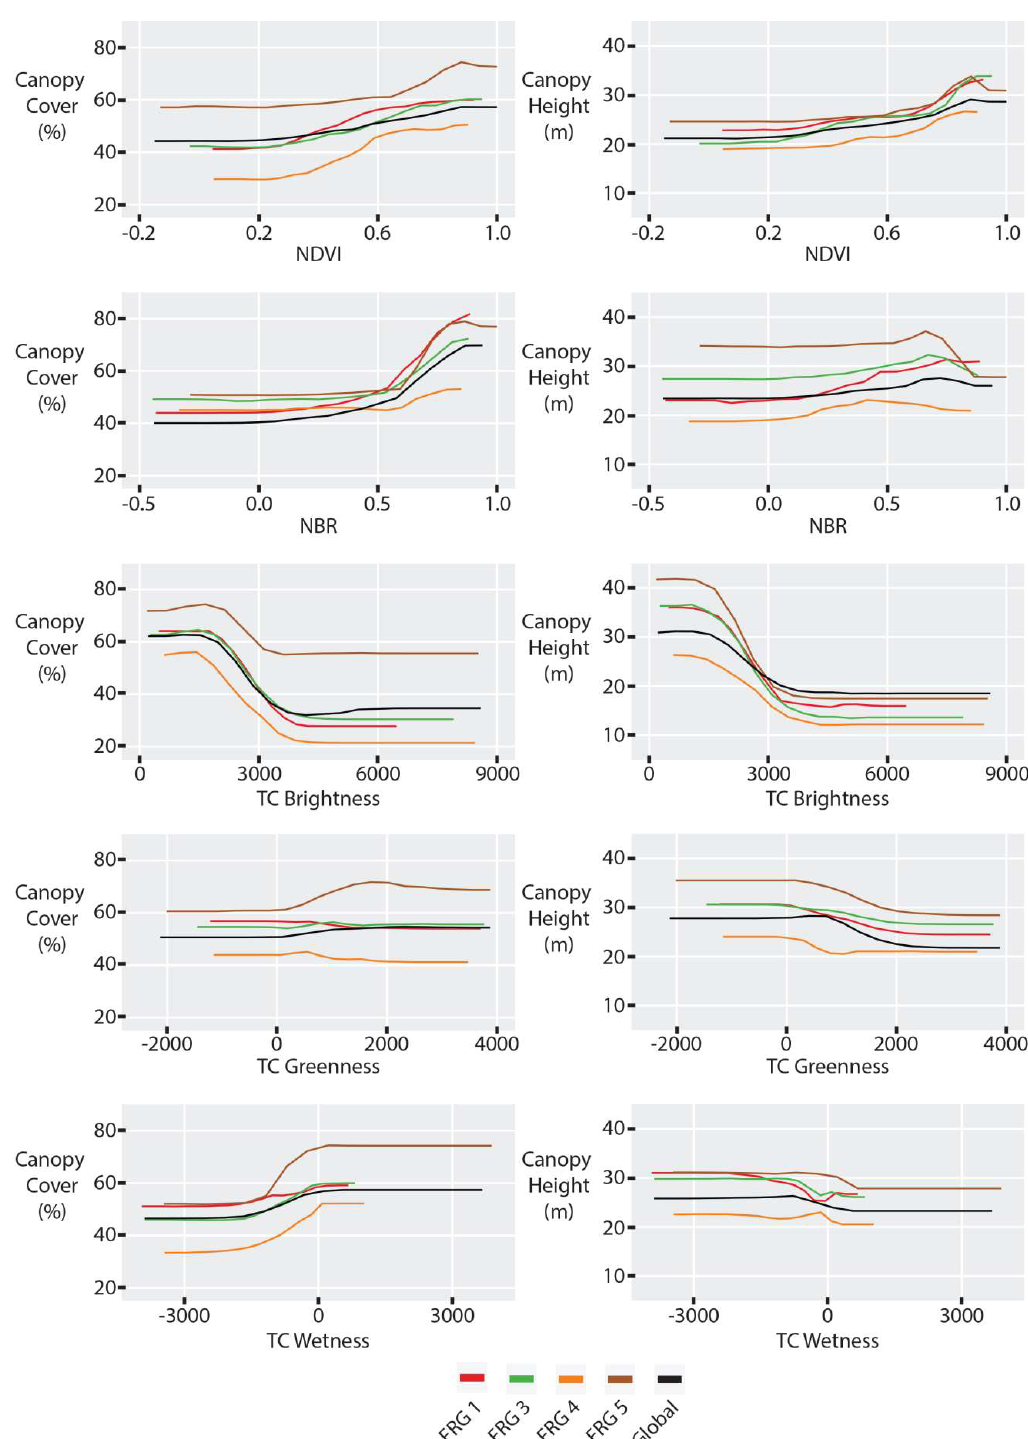
Figure 5. Partial dependence plots for each predictor variable (x-axes ) and the canopy cover and canopy height response variables ( y-axes ). Each line shows the partial dependence using the fire regime group ( FRG ; colored ) and global ( black ) landscape datasets.